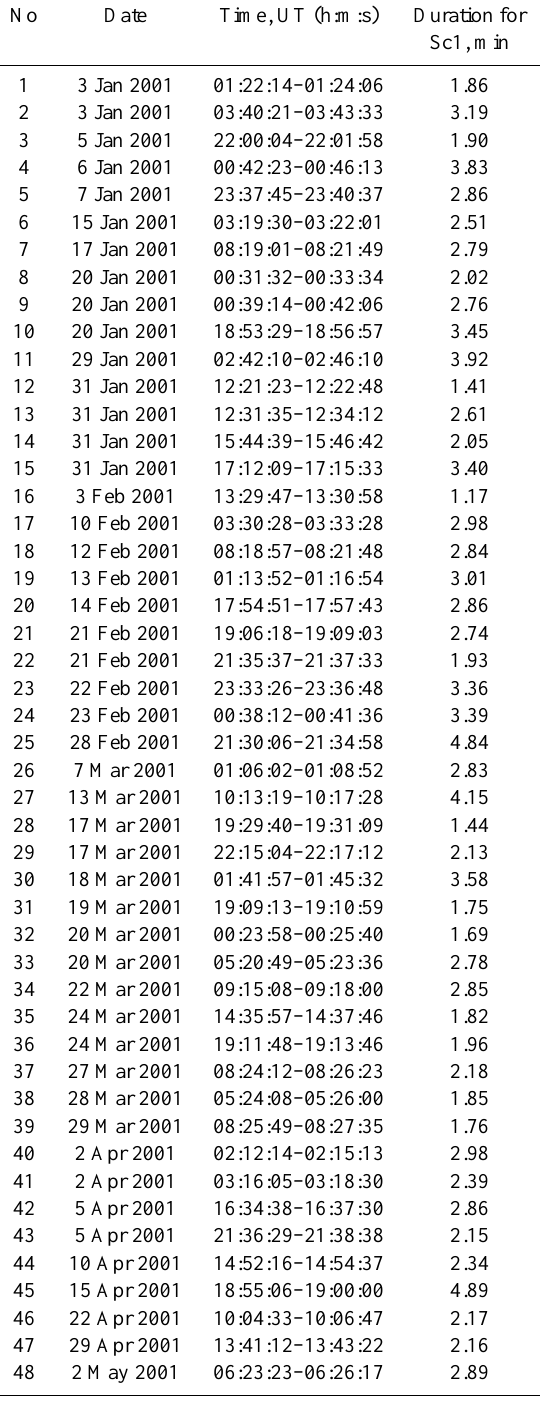
Table 1. The list of the events and their